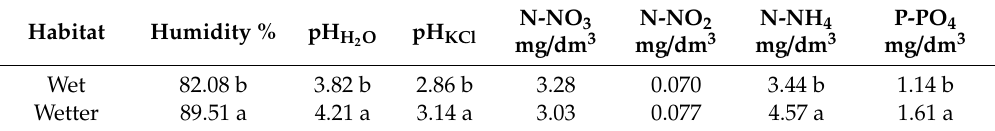
Table 4. Characteristics of birch bog habitats varied in terms of